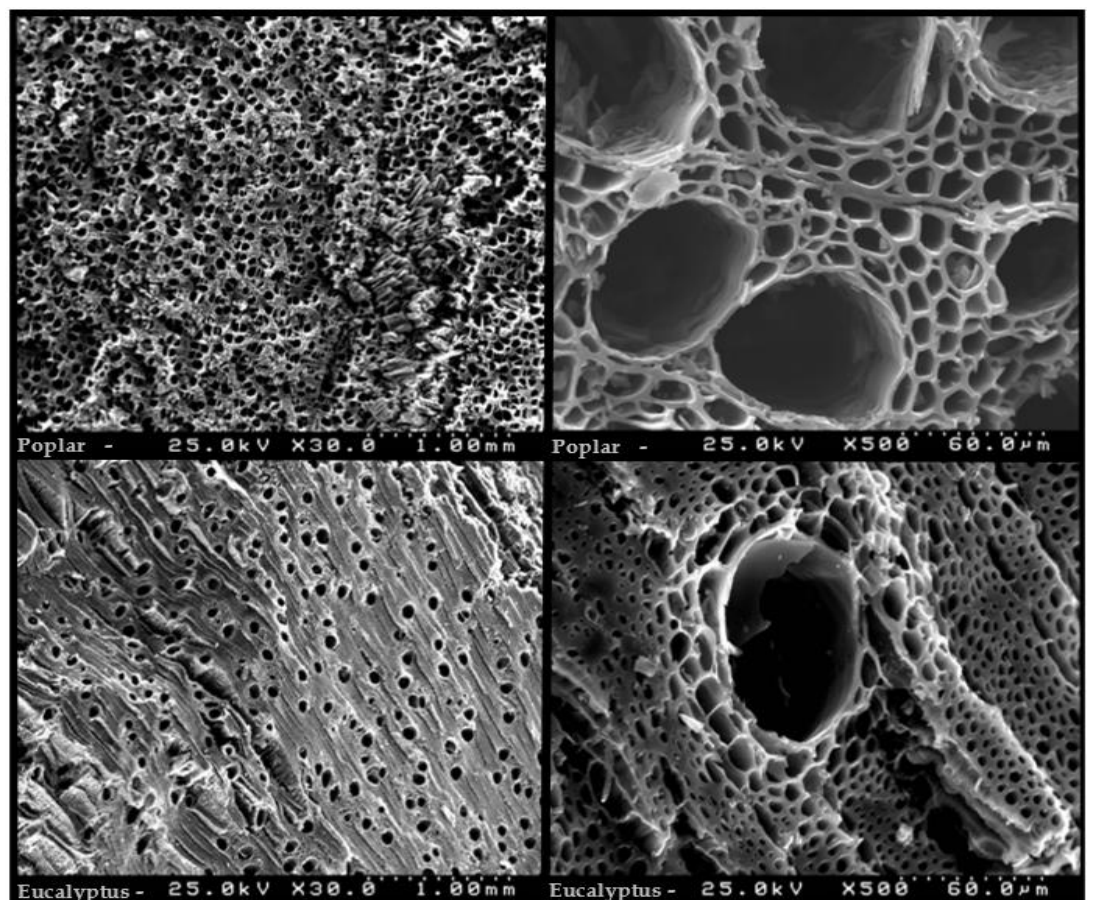
Figure 6. SEM micrographs of charcoals from poplar ( top ) and Eucalyptus globulus ( bottom ), as obtained at 400 °C and 1 °C/min, with a magnification of ×30 ( left ) and ×500 ( right ). The samples are shown in a cross-section cut perpendicular to the direction of the wood fibers.